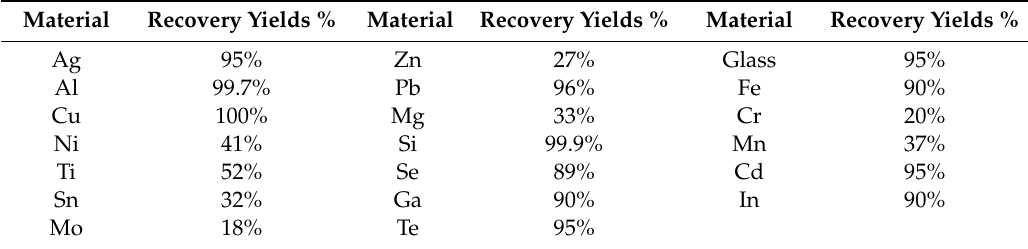
Table 3. The study of the proportion of recycled solar materials